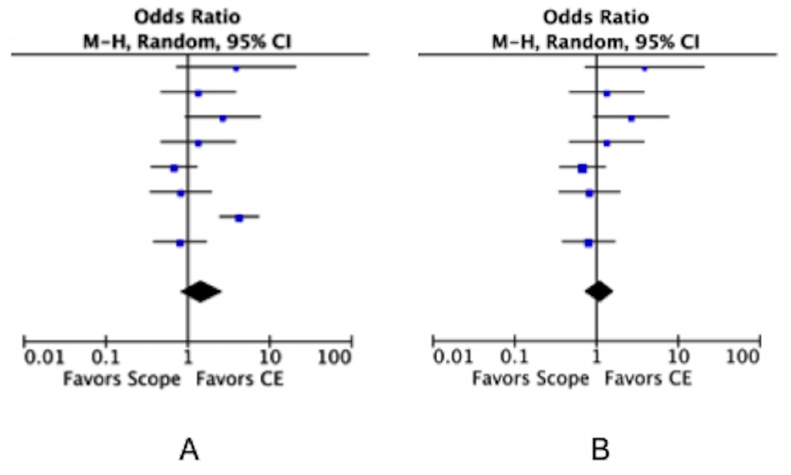
Fig 5. Forest plot of the odds ratio. A: Data including the overall studies. B: Data excluding the study of Marmo et al., [22].